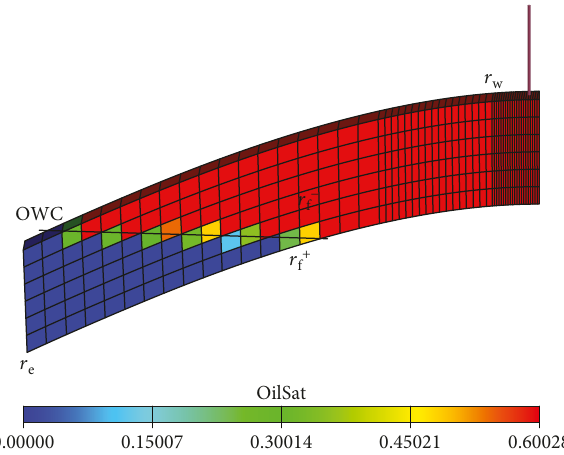
Figure 6: According to Buckley-Leverett theory, using saturation front, reservoir can be divided into three regions. The fi rst region is between the wellbore and the downstream side of saturation front, r < r < r − ; the second region is between the downstream w f side of saturation front and the upstream side of saturation front, r − < r < r + ; and the third region is between the upstream side of f f saturation front and outer boundary of the reservoir, r +